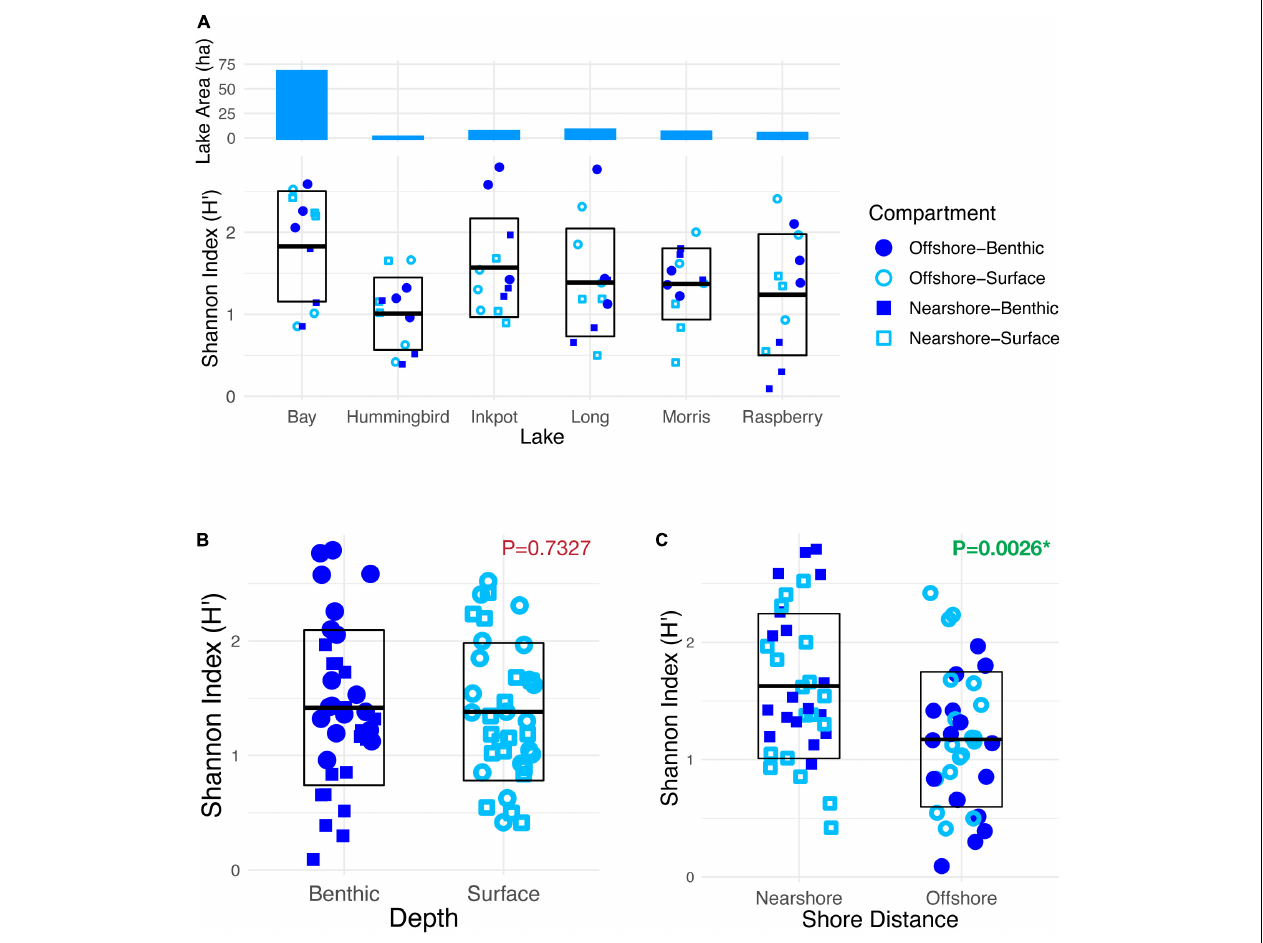
FIGURE 6 | Alpha diversity of combined plant and algal taxa detected by eDNA sampling in six lakes. (A) Distributions of Shannon’s diversity index (H’) for the 12 samples within each of six lakes, showing mean index value with one standard deviation above and below. Surface area of lakes is overlaid above (blue bars), showing a correspondence between lake size and mean alpha diversity (Spearman correlation: ρ = 0.94). (B) Shannon diversity for all surface vs. all benthic samples. Mean values are not significantly different. (C) Shannon diversity for all nearshore vs. all offshore samples. Mean nearshore alpha diversity is significantly higher than mean offshore diversity ( p < 0.005).